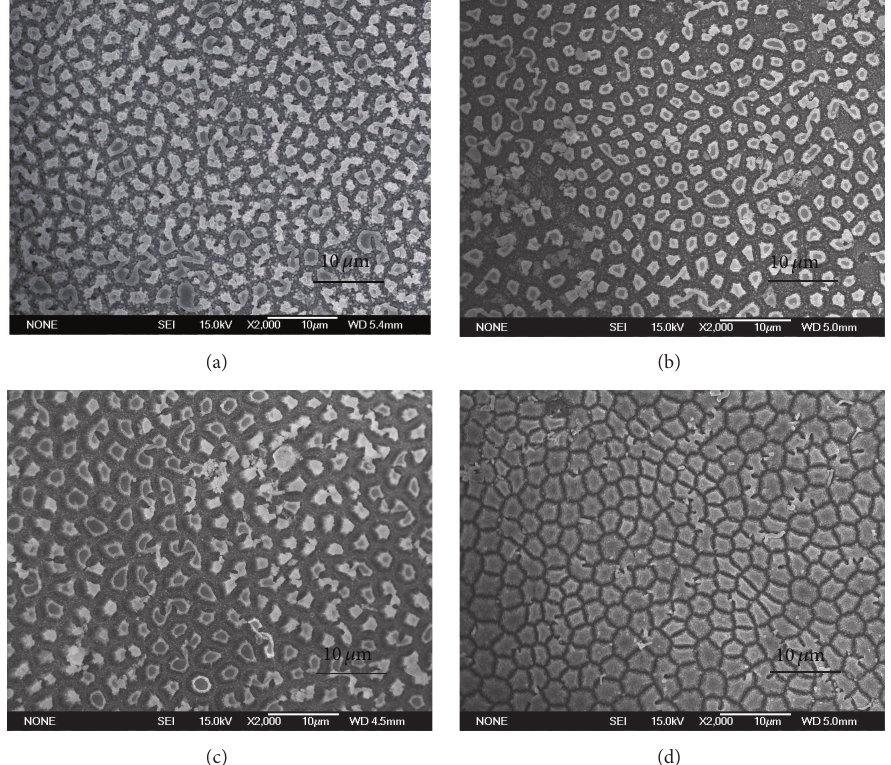
Figure 2: SEM images of CdS/Si-NPA, (a) 0mol L −1 , (b) 0.05 molL −1 , (c) 0.10 molL −1 , and (d) 0.15 molL −1 .